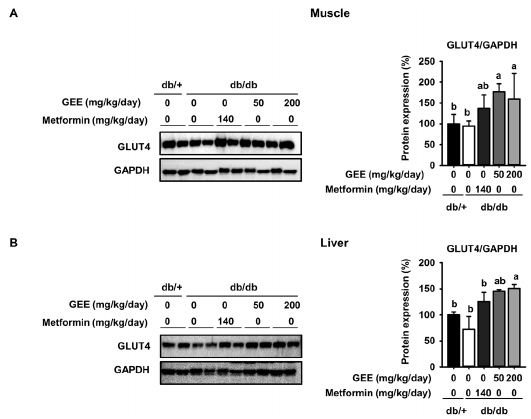
Figure 3. Effect of GEE on GLUT4 protein expression in the skeletal muscle and liver of db/db mice. Five-week-old mice were administered with or without GEE (50 and 200 mg/kg/day) for five weeks. GLUT4 was quantified by western blotting in the skeletal muscle ( A ) and liver ( B ). Protein expression was quantified after normalization to glyceraldehyde 3-phosphate dehydrogenase (GAPDH) using Image J software. Data were analyzed by a one-way ANOVA followed by Duncan’s test. Data are mean ± SD ( n = 8 per group, a p < 0.05, b p <